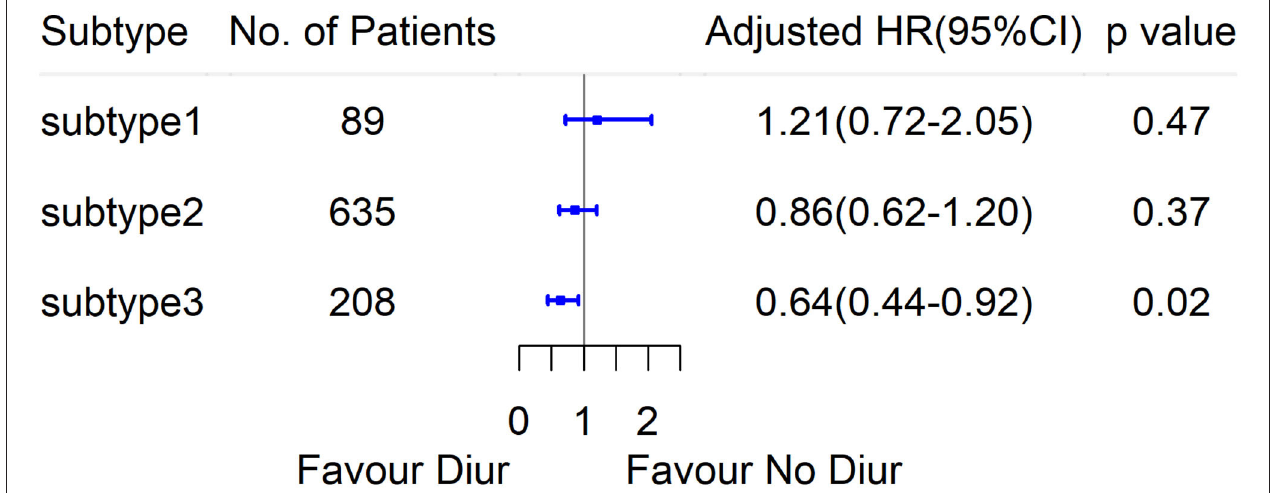
FIGURE 2 | Marginal structural Cox model HR values for 28-day mortality in diuretics and no diuretics group, according to the subtypes derived by LCA.